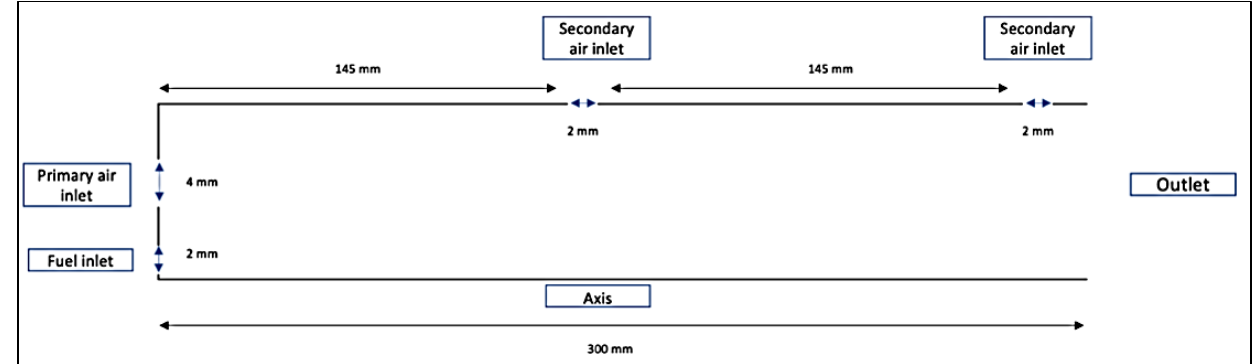
Figure 3. 2D Combustor geometry.